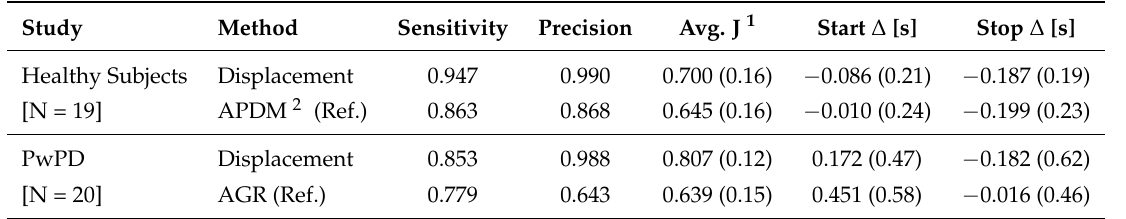
Table 2. Performance of the proposed method on the validation set for the healthy subjects and PD study. Results are presented as mean (SD) where